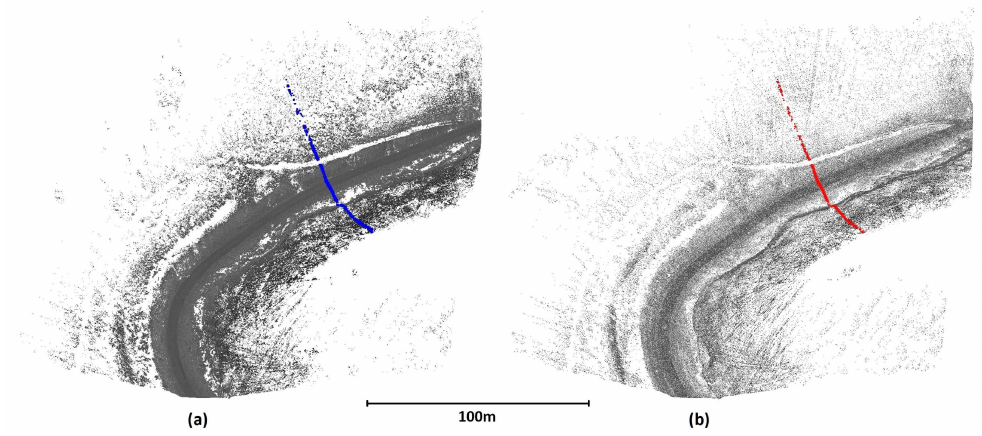
Figure 7. Site 2 after ( a ) CSF and ( b ) MDSR filtering; the profiles detailed in Figure 8 are indicated by blue (CSF) and red (MDSR)